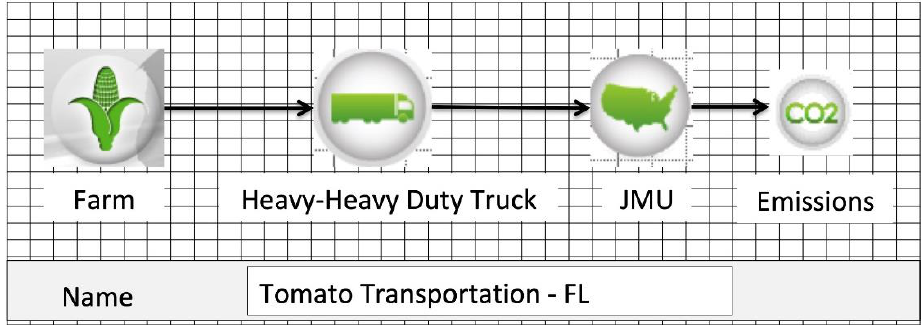
Figure 2. GREET-based transportation process for farm to dining services.